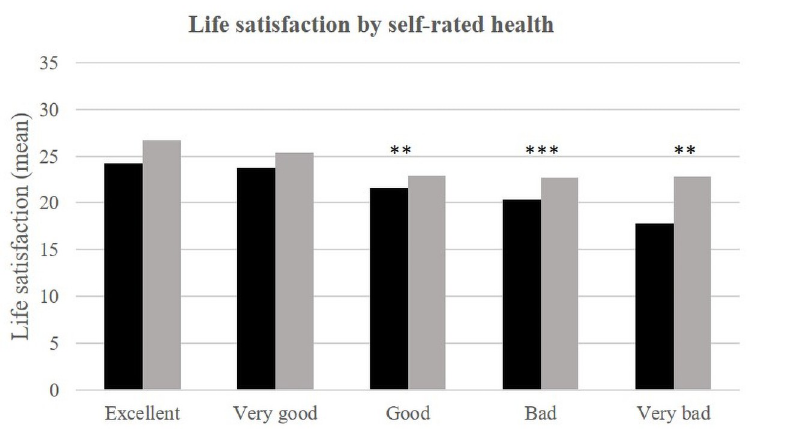
Fig 6. Life satisfaction (mean) by self-rated health and place of